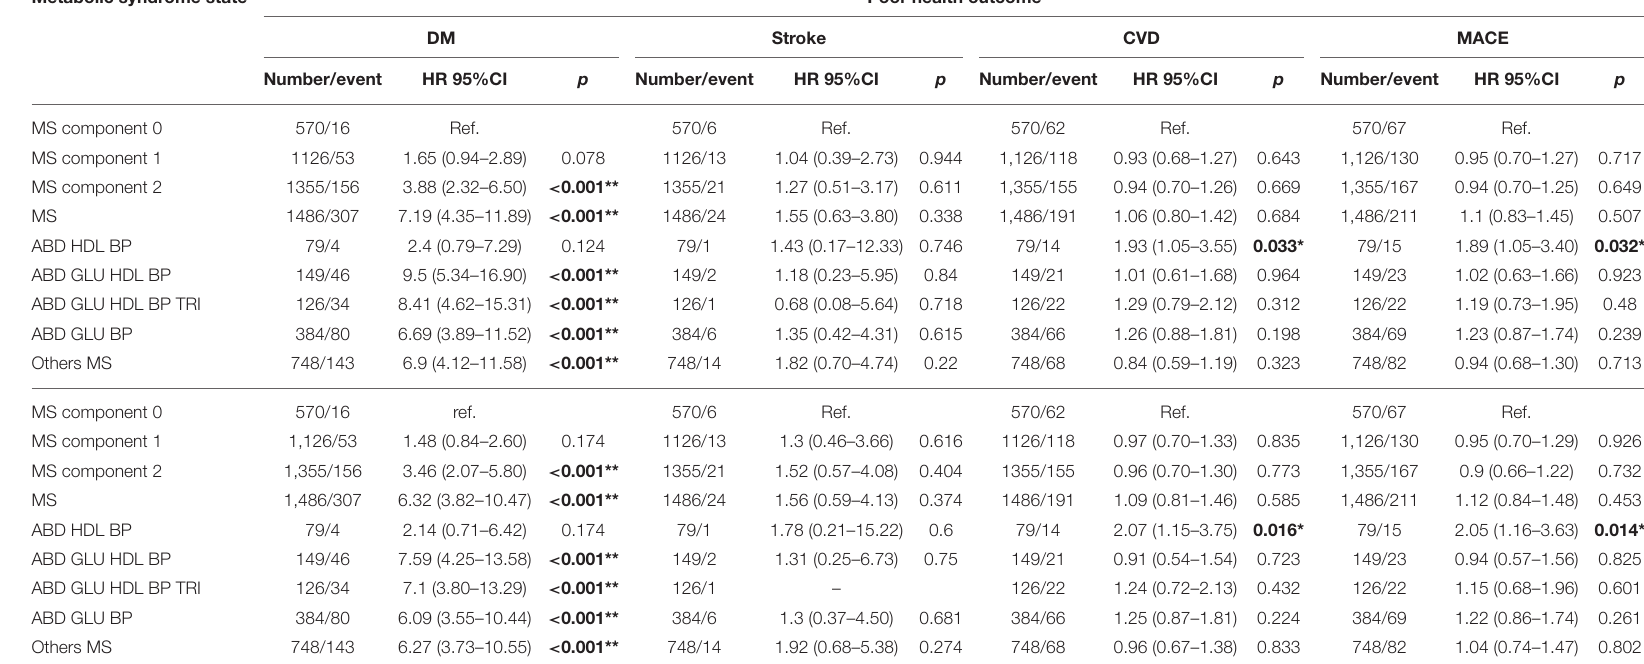
TABLE 6 | Poor health outcomes among different metabolic syndrome states. Metabolic syndrome state